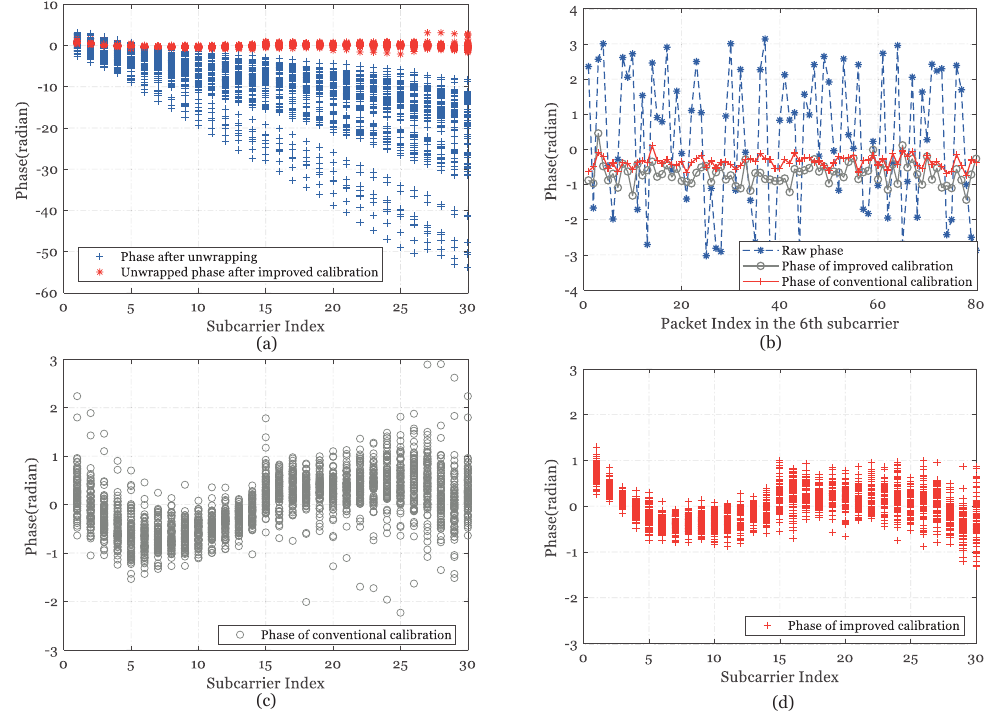
Figure 7. CSI phase calibration at NLOS position. ( a ) CSI phase in one antenna. ( b ) CSI phase after linear transformation in the first subcarrier. ( c ) CSI phase after conventional calibration. ( d ) CSI phase after modified